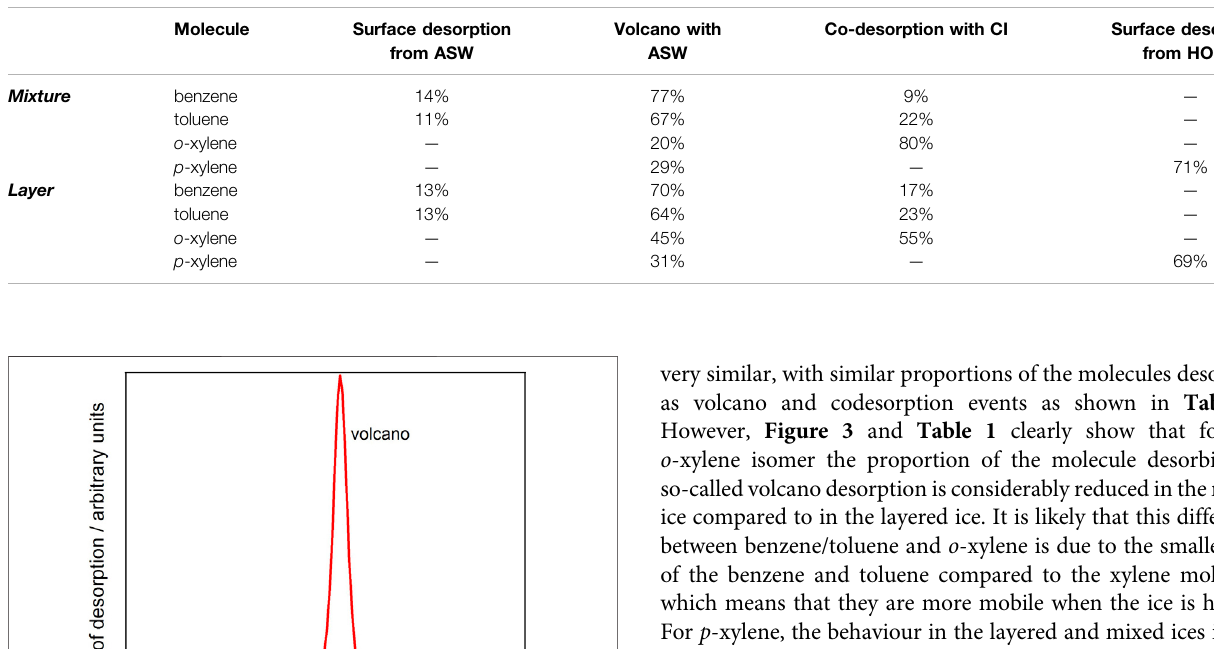
TABLE 1 | The percentage of each desorption component from ASW mixed and layered ices containing mostly water and a small amount of the aromatic molecule of interest.ThepercentagesarecalculatedfromtheintegratedareasundertheTPDpeaks(9 – 17%dataforthemixedices,andupto10L m ofthemoleculeona50L m layer of ASW).